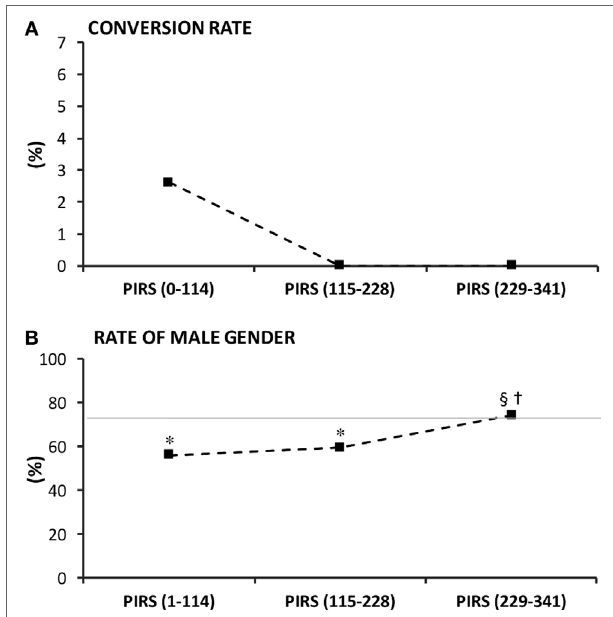
FigUre 4 | Confidence of the surgical team on the technique reflected by (a) conversion to open surgery rate, and (B) rate of male gender proposed for percutaneous internal ring suturing (PIRS). In (B) , the full horizontal line represents the overall rate of males among our population. p < 0.05 indicated significance: * vs. overall prevalence; § vs. lap (0–114); † vs. lap